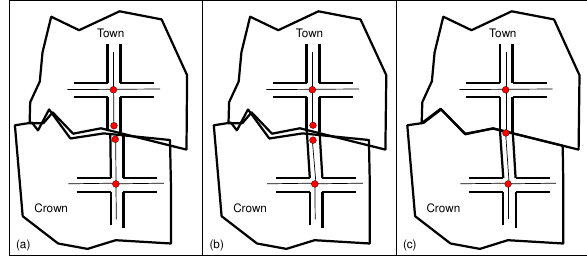
Figure 5. Network continuity between a town and its crown. (a) Preliminary situation with error discrepancies. (b) Merging roads so that the map looks good. (c) Merging nodes at the